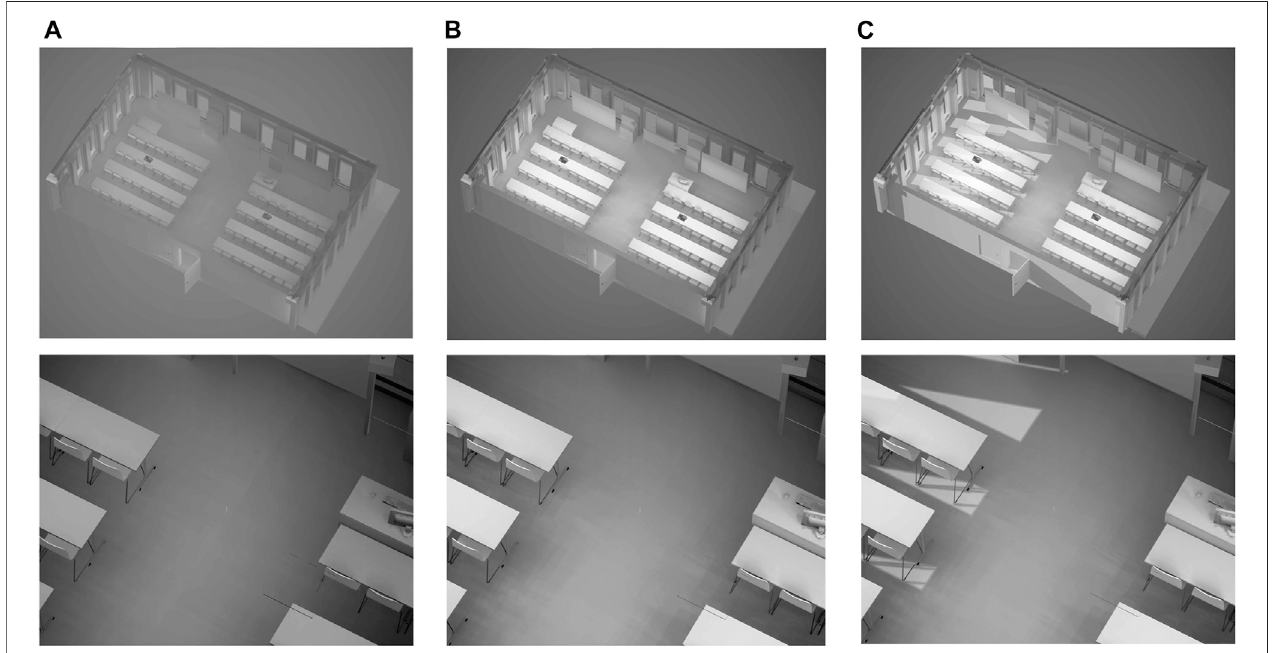
FIGURE2| Levelsofdetailforthelightingde fi nitionsofthevisualcues: (A)global lighting; (B)focal lighting,astworectangularlightsonthetableregions,together with global lighting; (C) directional lighting as sunlight, together with focal and global lighting.